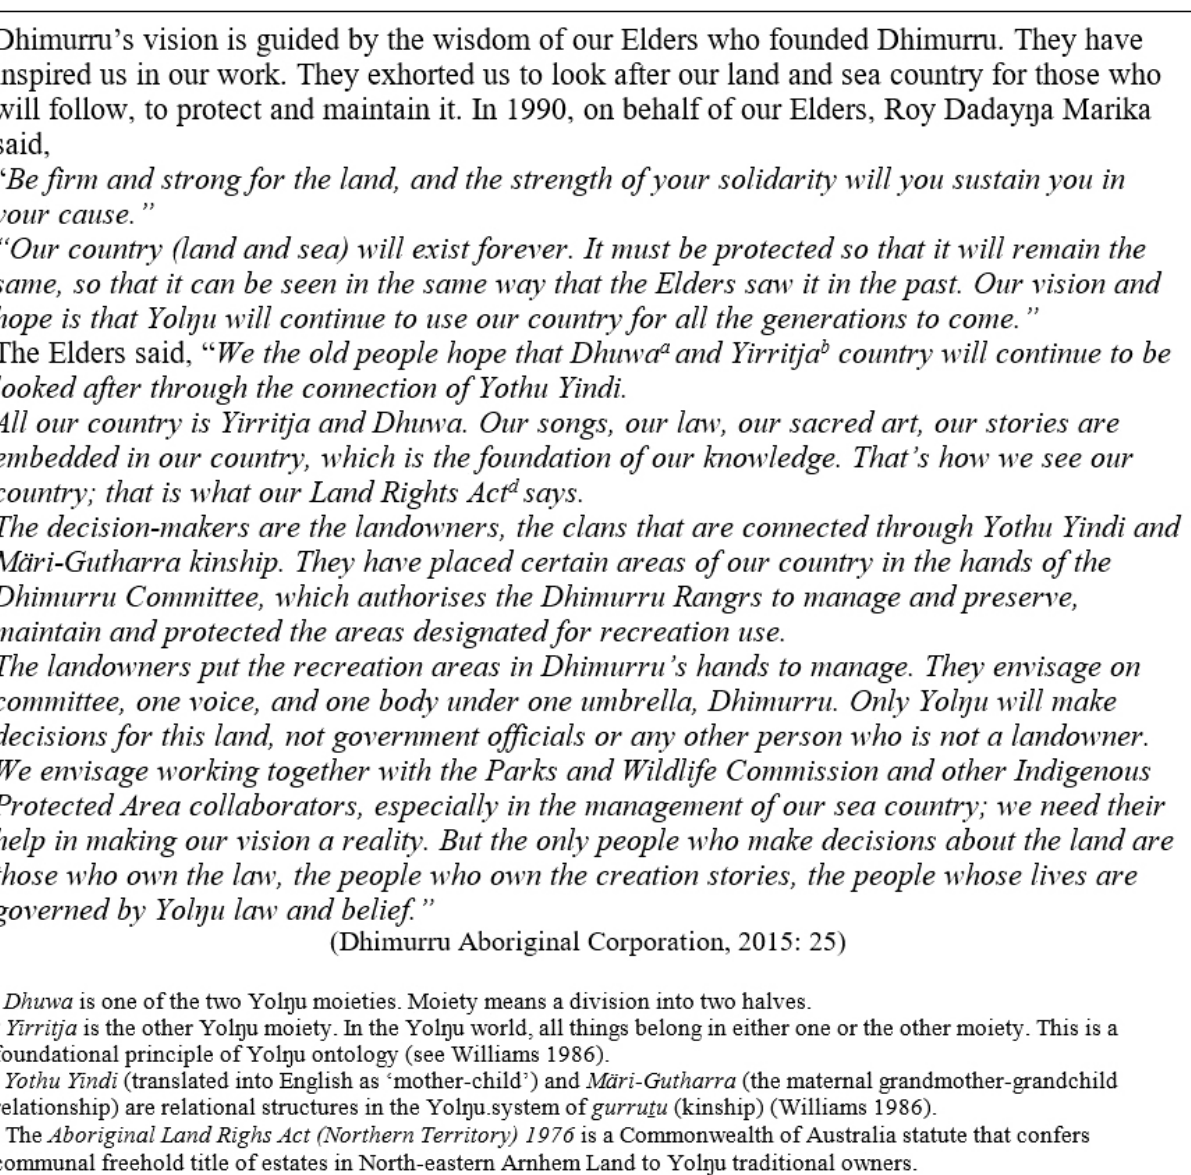
Fig. 2 . Dhimurru Vision